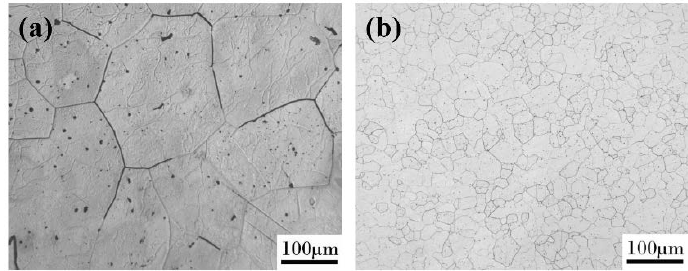
Figure 3. Surface morphology observed in an optical microscope: ( a ) as‐cast alloy; ( b ) hot‐rolled alloy.